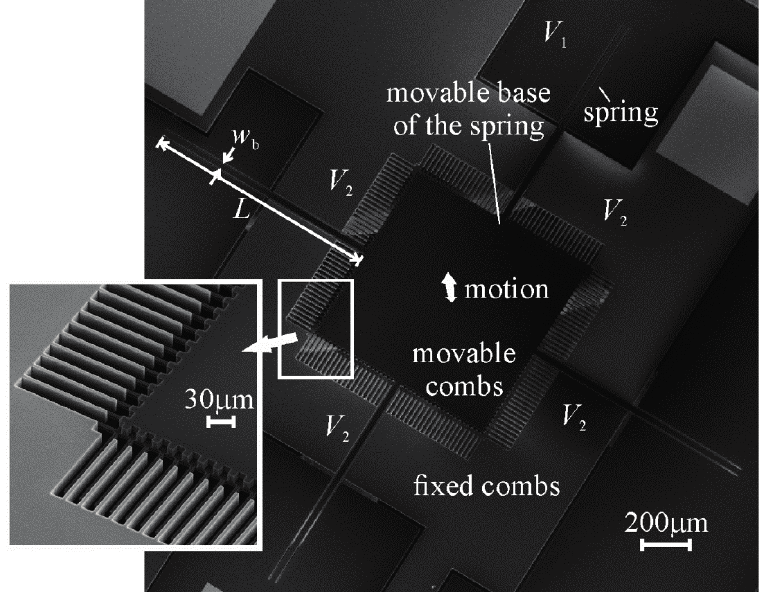
Figure 1. A vertical comb drive. Its components have been etched from the device layer of a silicon-on-insulator (SOI) wafer. The part of the handle wafer beneath its movable components has been removed. The thickness of its spring beams, t b , is equal to the thickness of the device